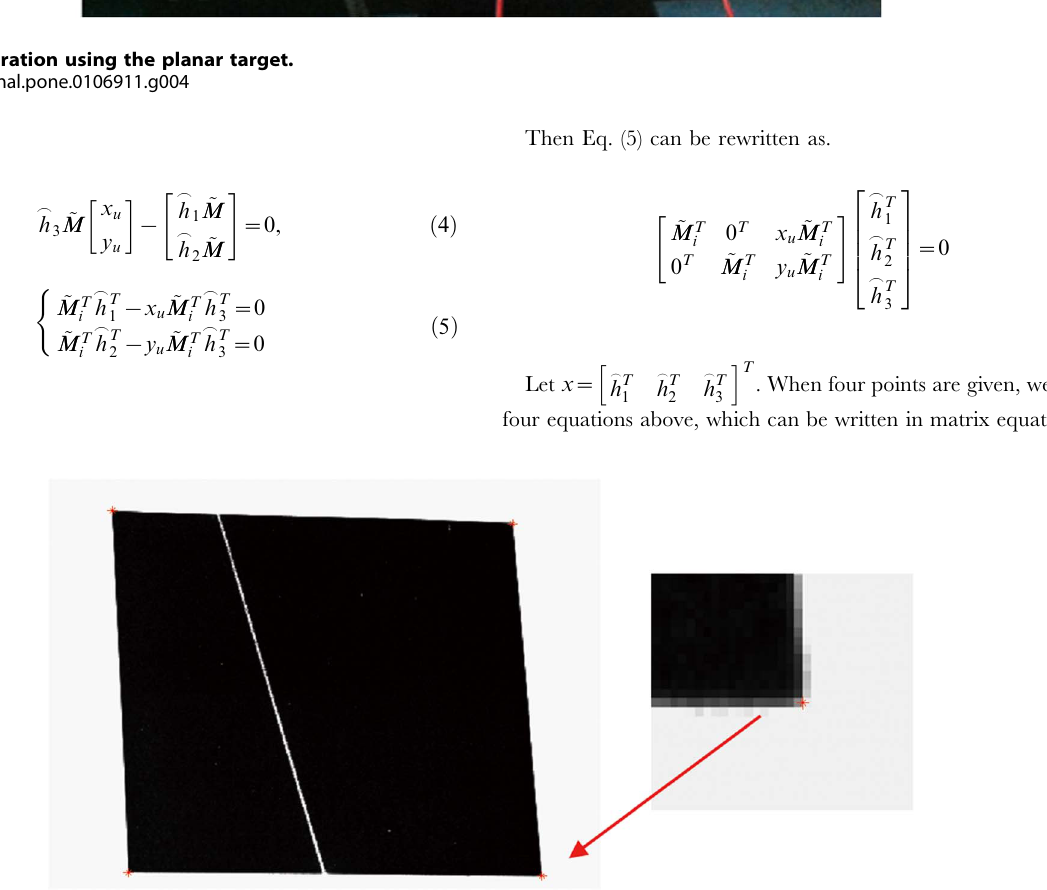
Figure 5. Corner points extraction.